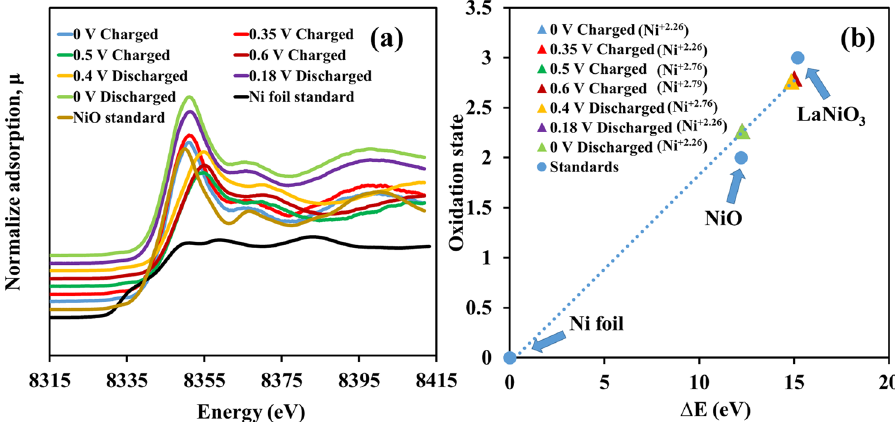
Figure 3. ( a ) In situ high-resolution Ni K-edge fluorescence XAS spectra of the as-prepared Ni(OH) 2 -N- rGO ae electrode and Ni standard compounds and ( b ) the oxidation states vs. Δ E (eV) of the Ni(OH) 2 -N-rGO ae electrode during charging/discharging by a chronoamperometry method at different applied potentials vs. Ag/ AgCl.